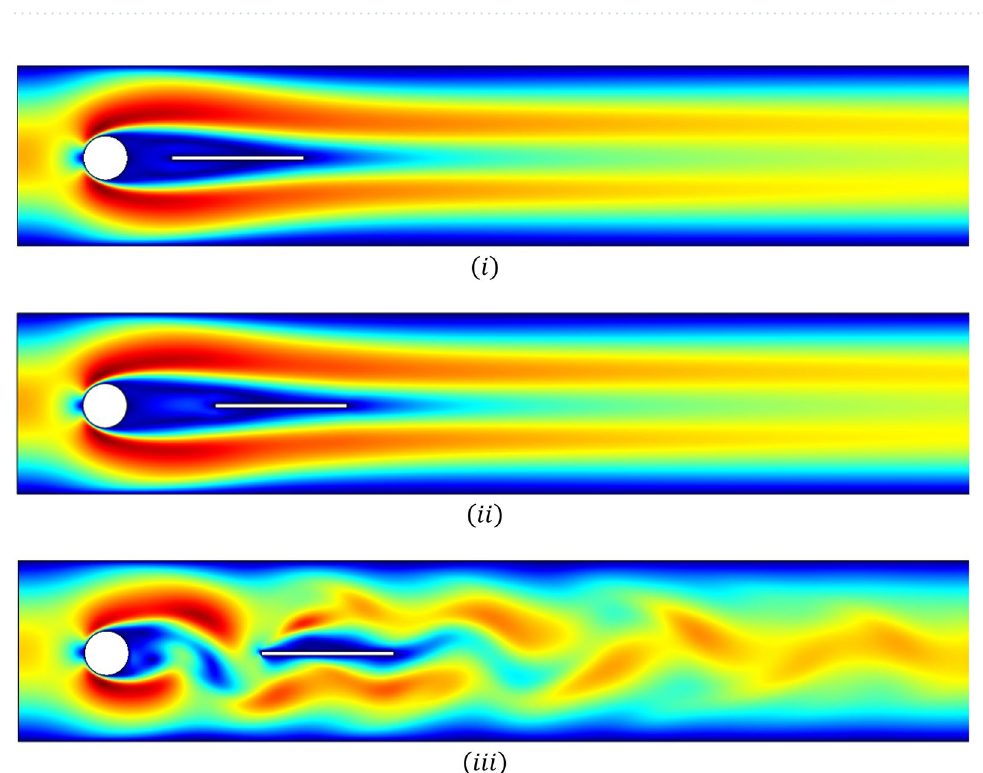
Figure 6. Influence of detached splitter plate (length L = 0.3 ) on velocity, placed at gaps ( i ) G 1 = 0.1, ( ii ) = 0.3 with Re = 100 at t = = 0.2, ( iii ) G G 3 2